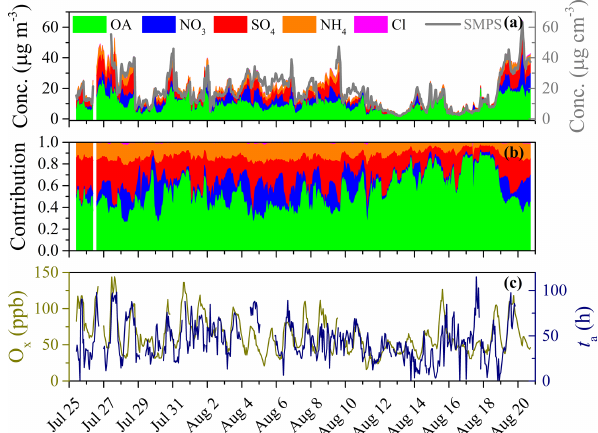
Figure 1. Overview of time series of (a) concentrations of NR-PM 1 species derived from HR-ToF-AMS (left y axis) and SMPS (right y axis), (b) relative contributions of NR-PM 1 species, and (c) con- centration of total oxidant (O x = O 3 + NO 2 ) and photochemical age ( t a ) during this field